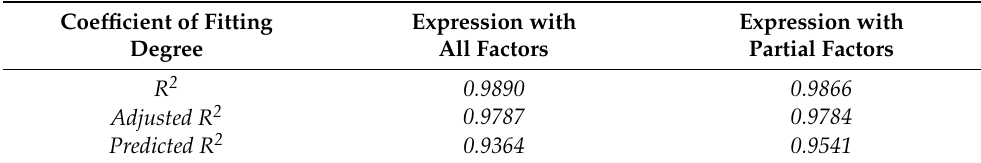
Table 4. Rationality evaluation for relational